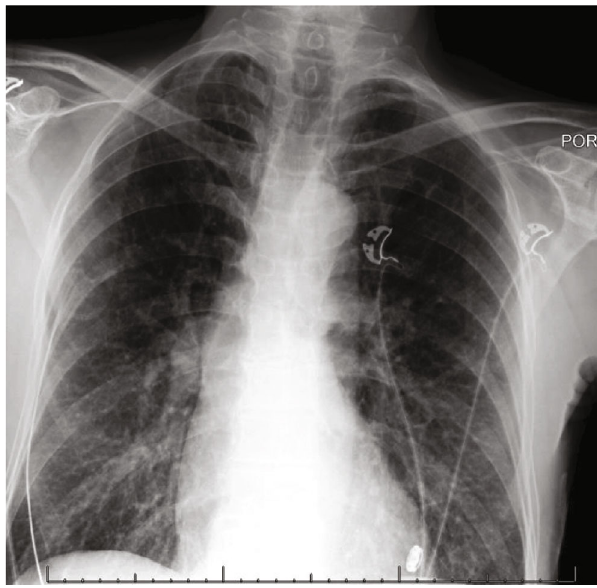
Figure 5: Chest X-ray revealing normal cardiac silhouette size. Mild interstitial edema bilaterally suggestive of CHF. No large e ff usion or dense consolidation.